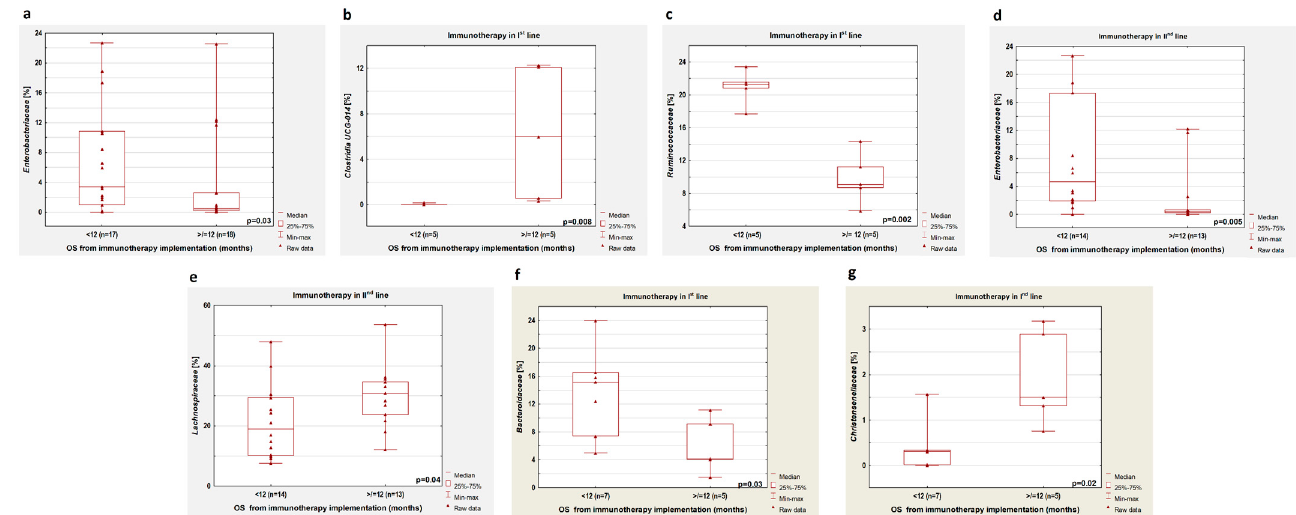
Figure 8. Differences in the abundance of individual bacteria in patients with OS shorter and longer than 12 months. Boxplots showing the content of ( a ) Enterobacteriaceae regardless of immunotherapy line; ( b ) Clostridia UCG-014 in first-line immunotherapy group; ( c ) Ruminococcaceae in first-line immunotherapy group; ( d ) Enterobacteriaceae in second-line immunotherapy group; ( e ) Lachnospiracea in second-line immunotherapy group; ( f ) Bacteroidaceae in first-line immunotherapy group; ( g ) Christensenellaceae in first-line immunotherapy group. Boxplots ( a – e ) show groups untreated with antibiotics before immunotherapy, while boxplots ( f , g ) concern patients treated and untreated with antibiotics.